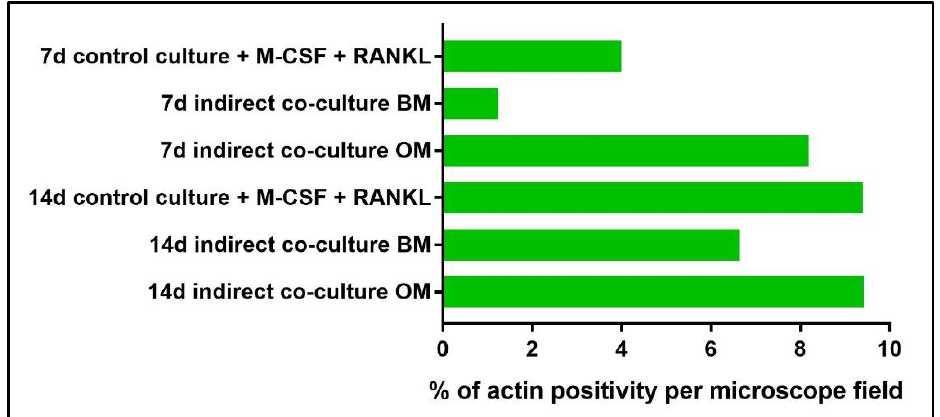
Figure 13. Diagram representing the percentage of area positively stained for actin filaments of PBMCs in both the single-cultures (control culture) and in indirect co-cultures exposed to basal medium (BM) or osteogenic medium (OM) for 7 and 14 days.